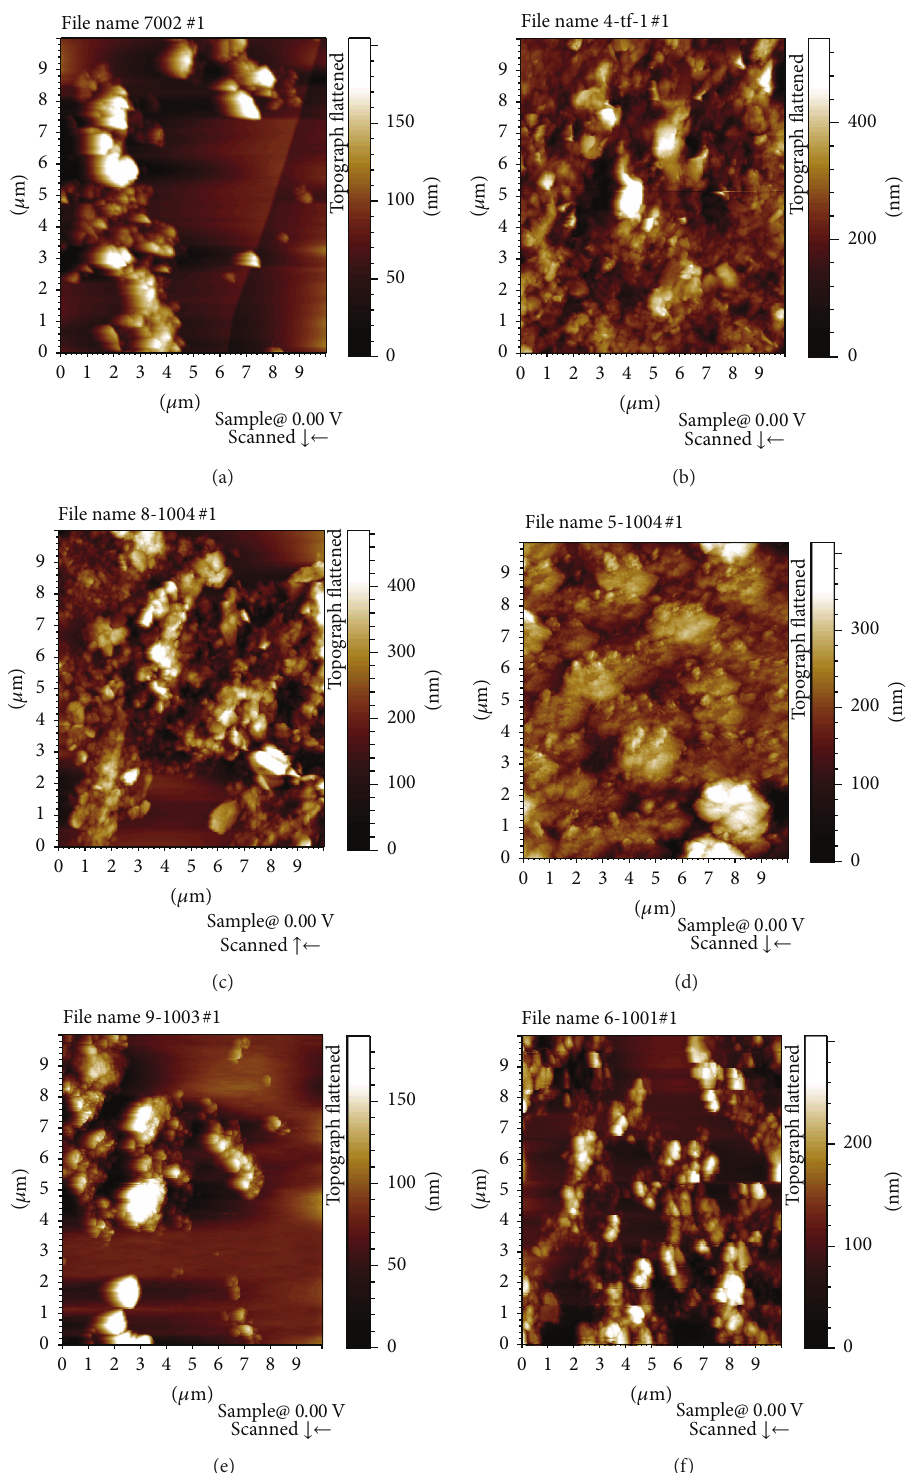
Figure 2: Atomic force microscopy images of soil colloids with (b, d, and f) and without (a, c, and e) fungus extract addition. (a) Colloids from the surface layer of dark brown forest soil; (b) colloids from the surface layer of dark brown forest soil + fungus extract; (c) colloids from the deep layer of dark brown forest soil; (d) colloids from the deep layer of dark brown forest soil + fungus extract; (e) colloids from saline-alkali soil; (f) colloids from saline-alkali soil + fungus